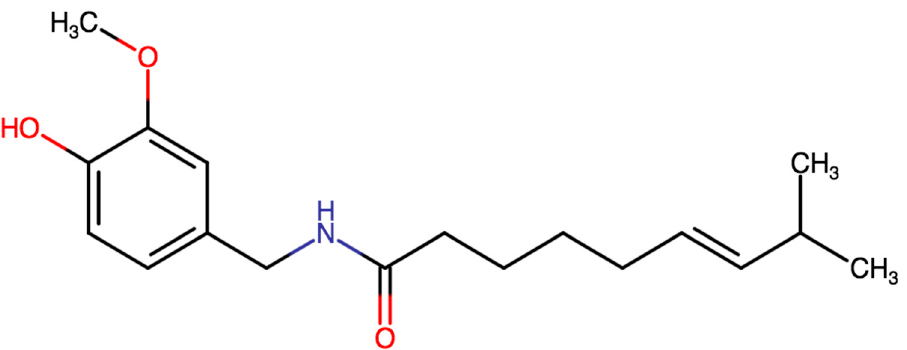
Figure 1. Chemical structure of capsaicin.